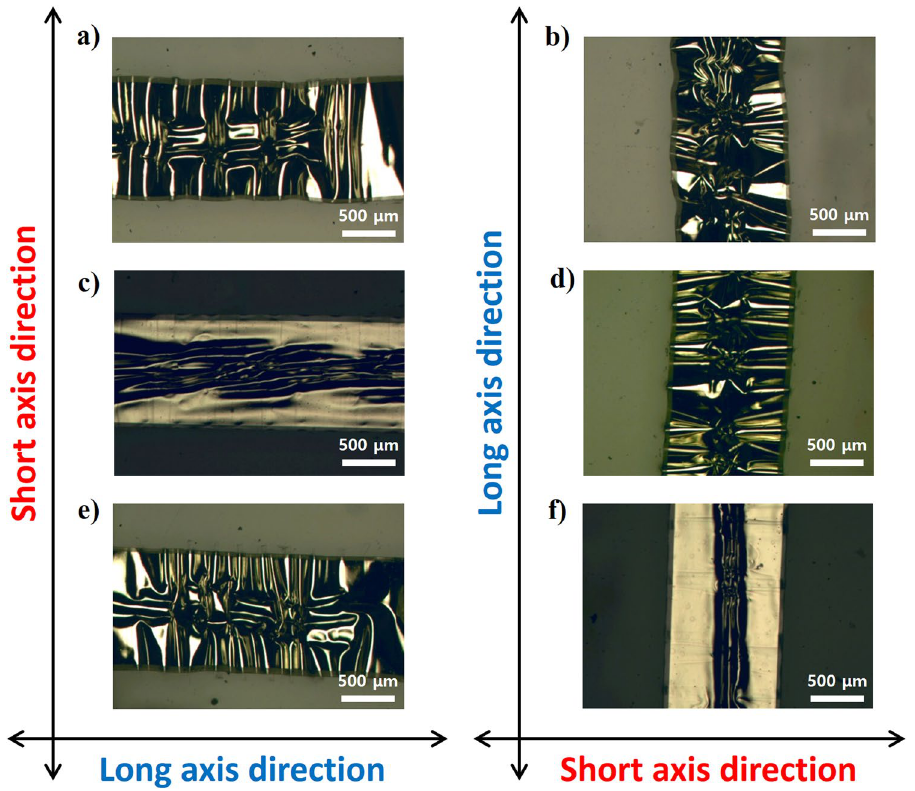
Figure 3. Optical images of cross-buckled aluminum electrodes ( a , b ) before stretching, ( c , d ) after stretching in x-axis direction, and ( e , f ) after stretching in y-axis